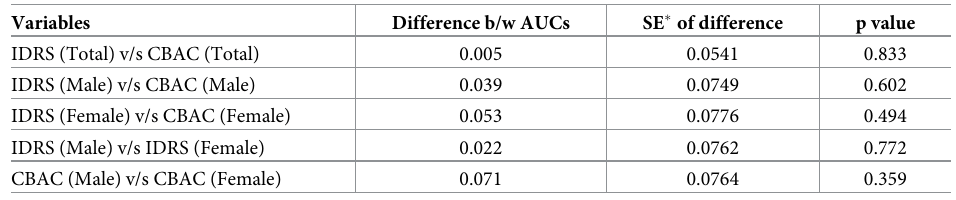
Table 3. Statistical comparison of all the ROC curves of IDRS and CBAC